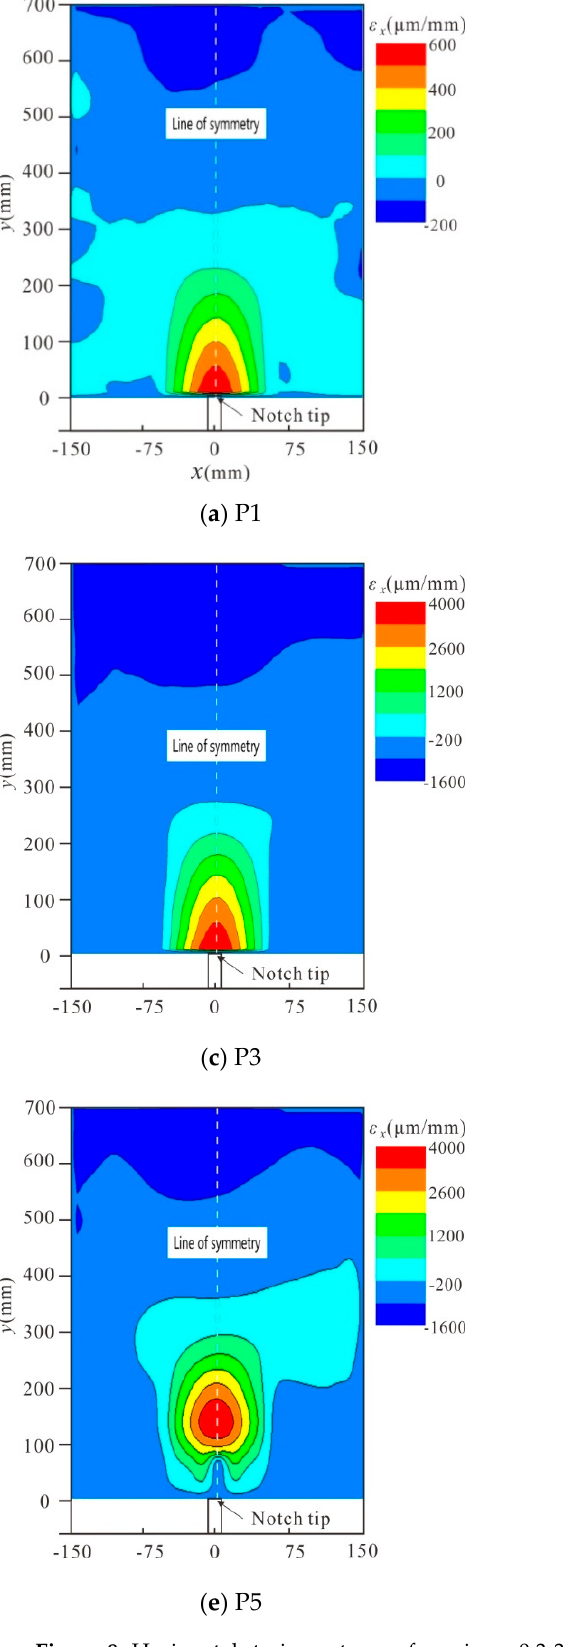
Figure 8. Horizontal strain contours of specimen 0.3-3 at different load points: ( a ) P1; ( b ) P2; ( c ) P3; ( d ) P4; ( e ) P5; ( f ) P6.